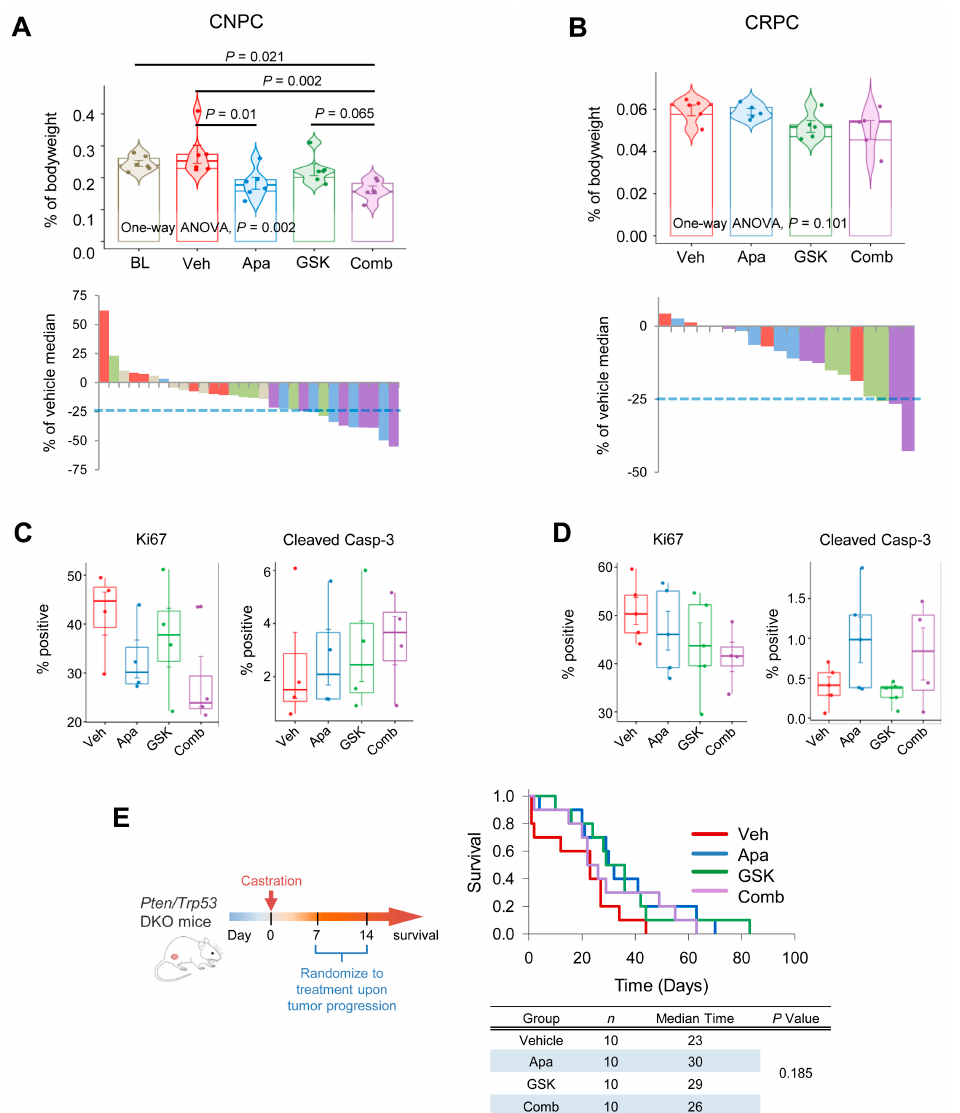
Figure 6. Efficacy evaluation of apalutamide and AKT inhibition in a mouse Pten -deficient prostate cancer. For castration- naïve prostate cancer (CNPC), 18-week-old Pten -KO mice were randomized to baseline (BL), vehicle control (Veh), apalu- tamide (30 mg/kg, p.o., 5 times/week), GSK690693 (GSK, 10 mg/kg, i.p., 5 times/week) or combination (Comb) groups ( n = 6 mice/group) and were treated for four weeks. For castration-resistant prostate cancer (CRPC), 12-week-old Pten -KO mice were orchidectomized and randomized to Veh, Apa, GSK and Comb groups ( n = 6 mice/group). Mice were dosed with the appropriate treatment four weeks beginning at 18 weeks of age. Comparison of tumor burden based on the prostate weight relative to bodyweight and waterfall plots showing the individual treatment responses in the CNPC ( A ) and CRPC ( B ) intervention models. Horizontal bars represent the mean ± SE, center lines show the medians and box limits indicate the 25th and 75th percentiles, and the violin plots show the distribution where circles represent the individual samples. p values indicate significance of the Student–Newman–Keuls post hoc test for individual comparisons, upon a significant one-way ANOVA. Immunohistochemical quantification of cancer cell proliferation (Ki67) apoptotic rates (cleaved caspase-3) in CNPC ( C ) and CRPC ( D ). Horizontal bars represent the mean ± SE, center lines show the medians and box limits indicate the 25th and 75th percentiles, and violin plots show the distribution where circles represent the individual samples; n = 4 samples/group. ( E ) The therapeutic benefit of apalutamide was assessed in a late-stage model of advanced CRPC using PSA Cre ; Pten loxP/loxP /Trp 53loxP/loxP (DKO), as shown, and the Kaplan–Meier plots compare the overall survival curves for mice according to treatment. Unless indicated, a p value indicates the significance of the Log rank We next sought to determine whether adding an AKT inhibitor to apalutamide would impact long-term survival in an advance model of CRPC. Pten/Trp53 -DKO were randomized to the vehicle, apalutamide (30 mg/kg, p.o. 5 times/week), GSK690693 (10